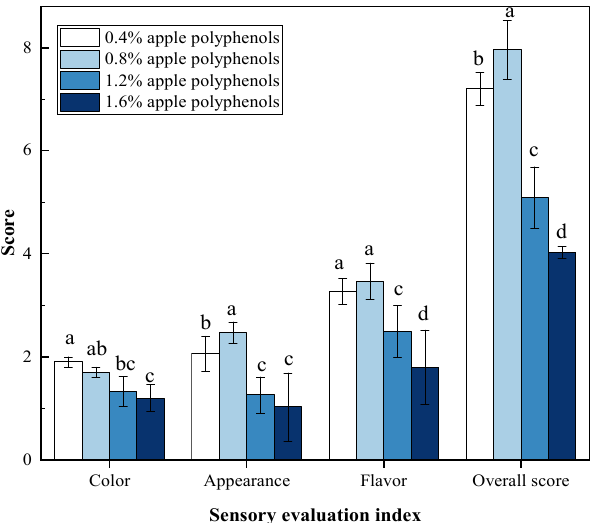
Figure 6. Effect of different apple polyphenol contents on the sensory evaluation of 3D-printed Figure 6. E ff ect of di ff erent apple polyphenol contents on the sensory evaluation of 3D-printed pro- processed cheese samples. Different letters in the figure indicate significant differences between cessed cheese samples. Di ff erent le tt ers in the fi gure indicate signi fi cant di ff erences between values values ( p < ( p < 0.05).